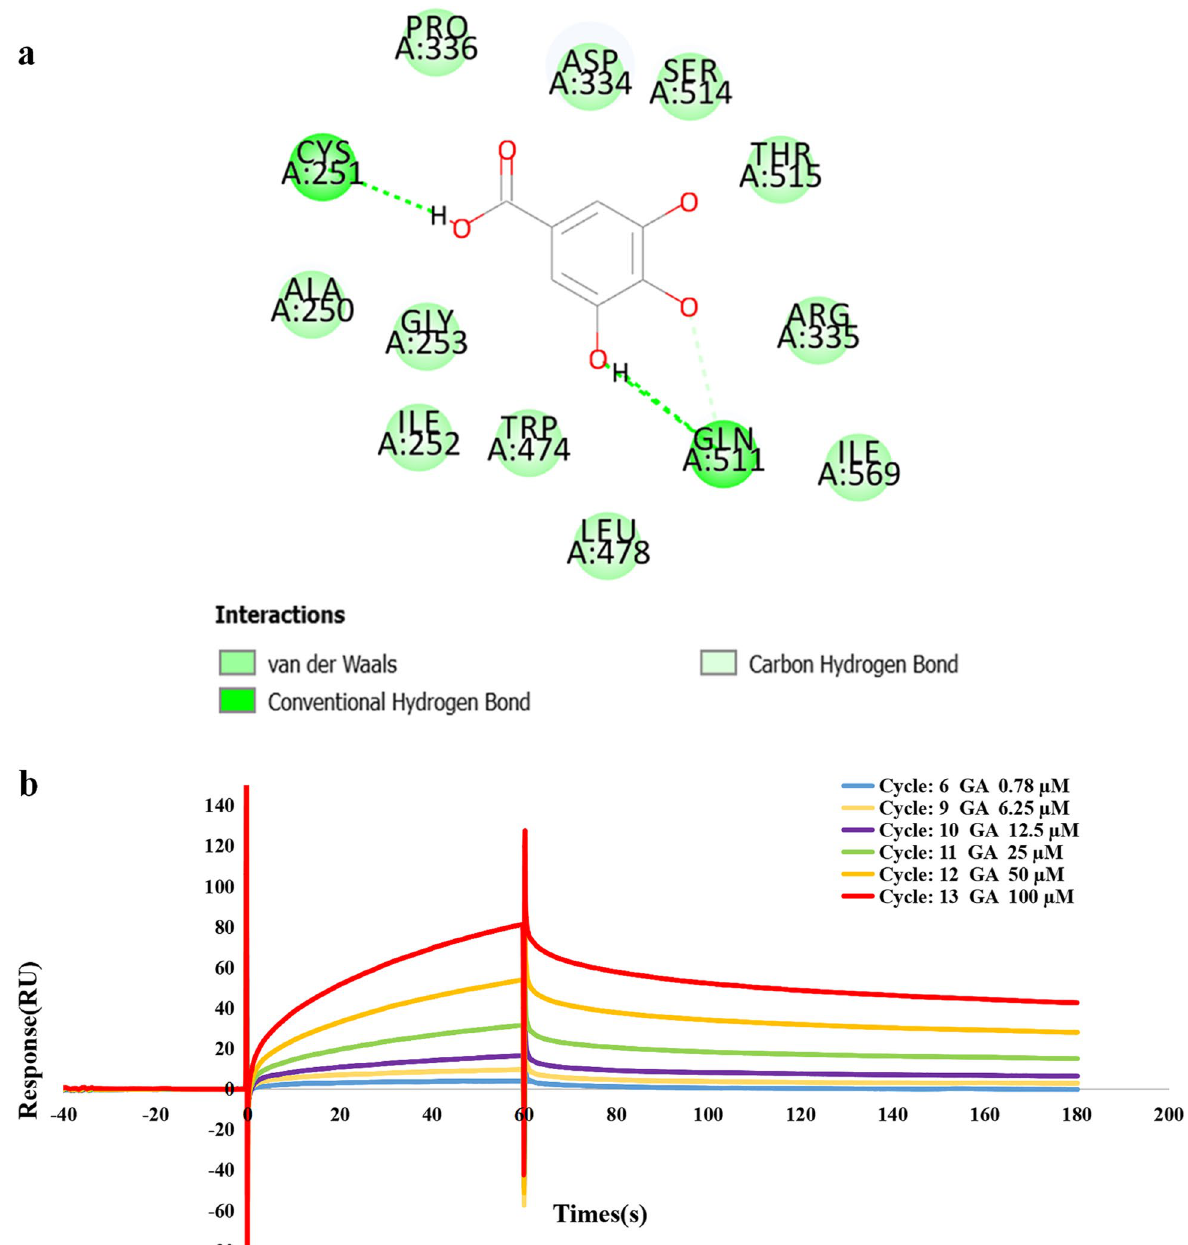
Fig. 6 The interaction between GA and STAT3. a Molecular docking analysis; b SPR